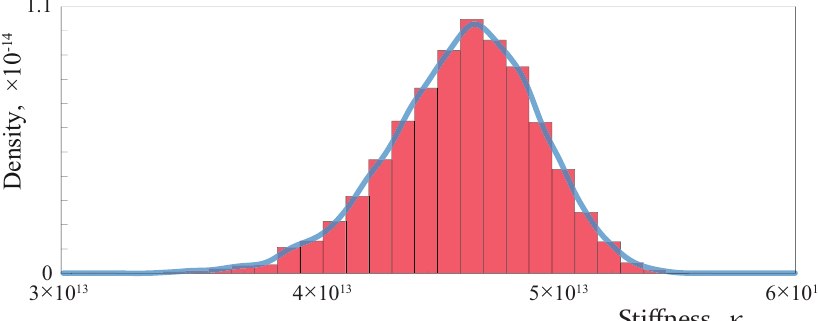
Figure 6. Histogram and the corresponding empirical density function of the spring stiffness κ calculated at M =